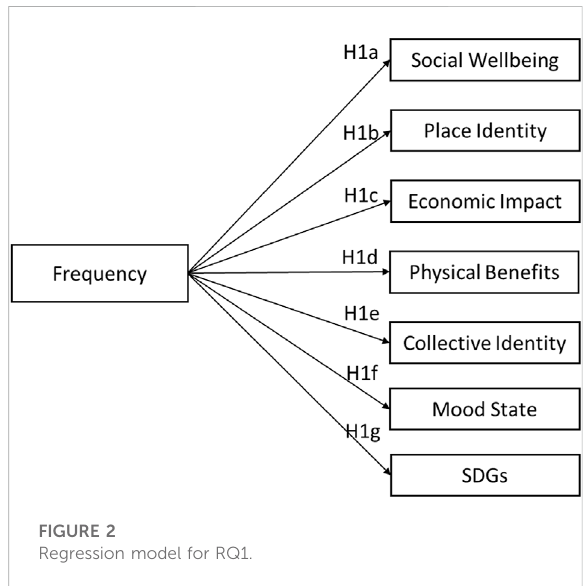
FIGURE 2 Regression model for